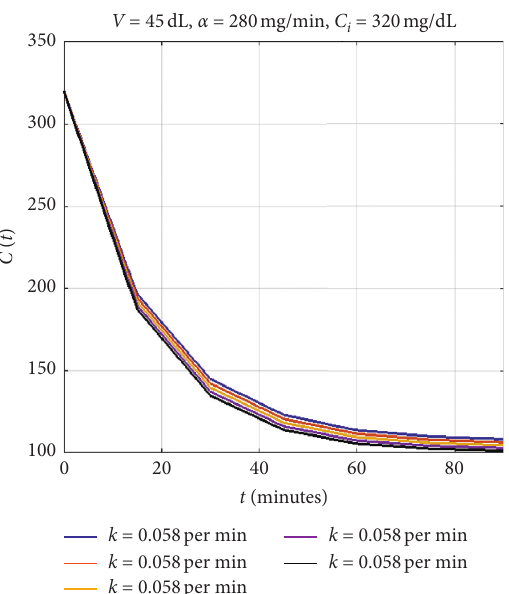
Figure 2: Blood glucose concentration C ( t ) for different values of volume in which glucose is distributed V and time t with. C